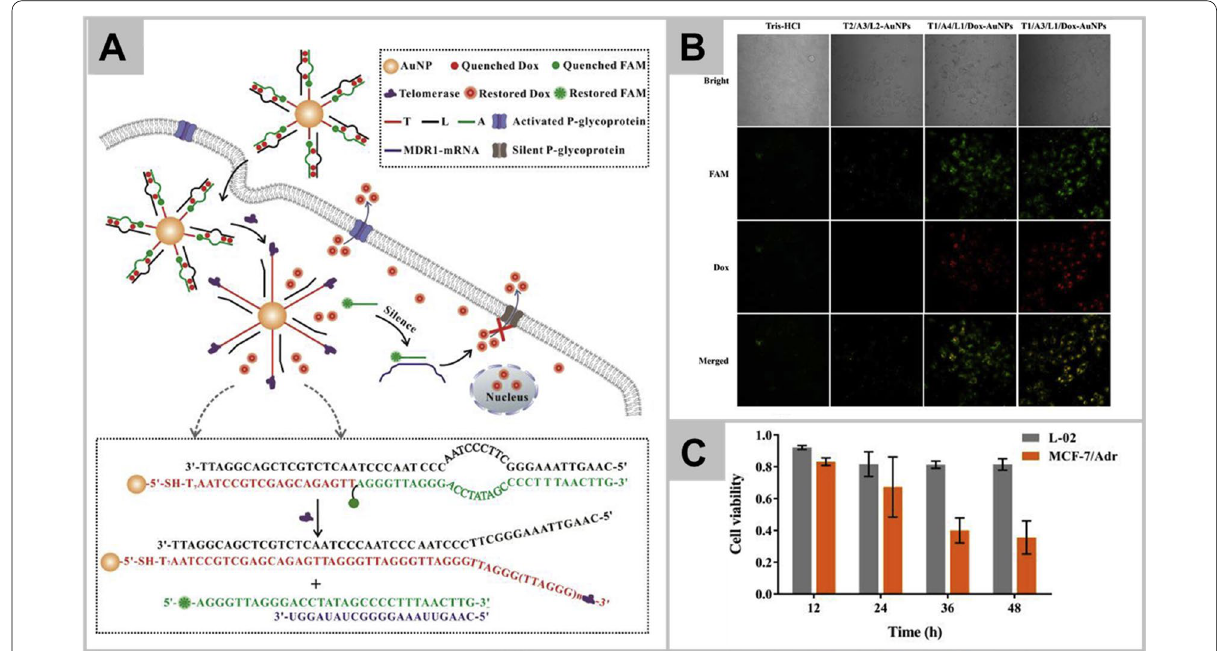
Fig. 2 Schematic illustration of nanoprobe for integrating diagnosis and treatment in multidrug resistance (MDR) tumor cells, wherein, the frame displays the sequence information for the entire reaction (Panel A ). The confocal fluorescence images of intracellular doxorubicin (DOX) accumulation in MCF-7/Adr cells with different treatments of Tris–HCl, T2/A3/L2-gold nanoparticles (AuNPs), T1/A4/L1/Dox-AuNPs, and T1/A3/L1/ Dox-AuNPs (Panel B ). The therapeutic effect of the proposed nanoprobe on MCF-7/Adr cells and L-02 cells at different time is also shown (Panel C ). Reprinted with permission from Talanta, Copyright 2020, Elsevier